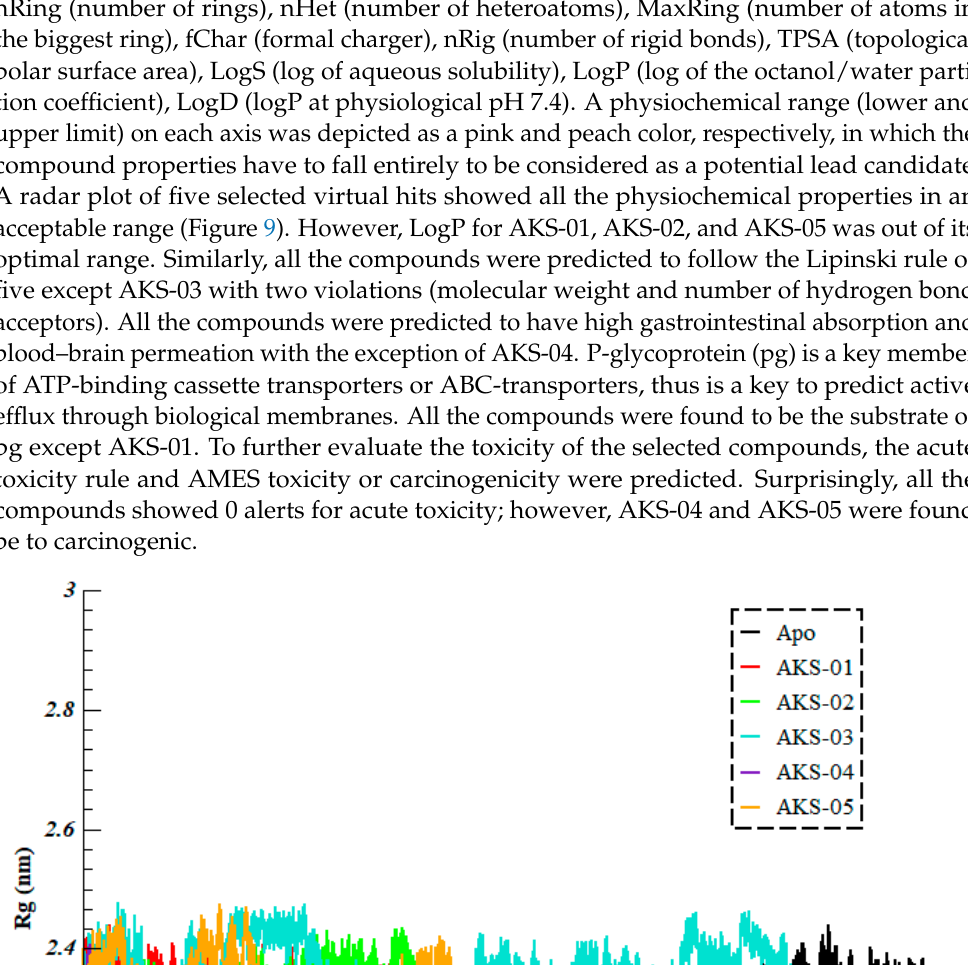
Figure 8. Hydrogen bonds between the interfacial residues of RBD residues and the five selected compounds throughout the 100 ns of simulation. 2.5. In Silico ADMET Analysis Poor pharmacokinetics and toxicity of a drug candidate are the main reasons for the clinical failure of drug development. In the earlier process of drug development, in silico prediction of ADMET properties of lead compounds is an alternative to experimental techniques to increase the success rate of clinical development. Herein, physiochemical,